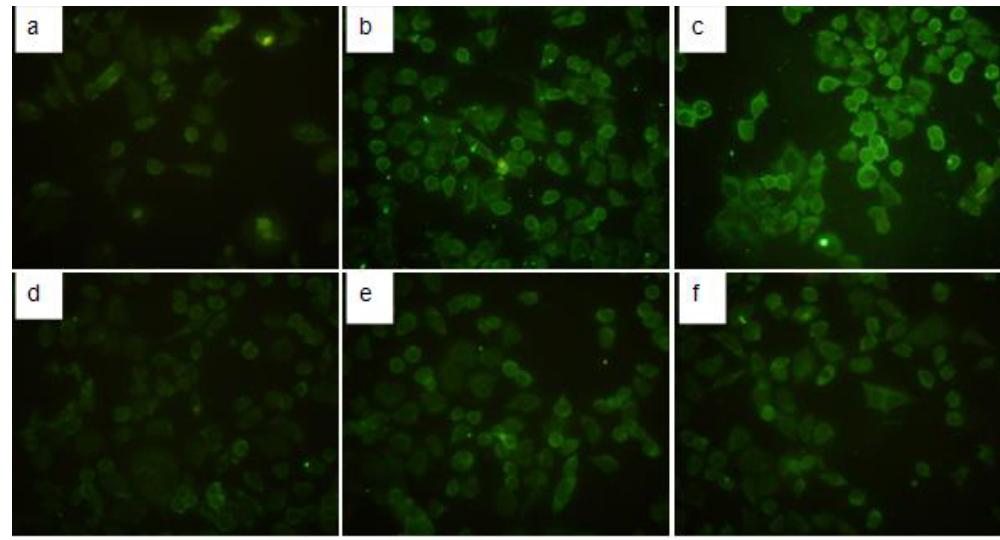
Figure 6. The comparison of TGF- β 1 Immunofluorescence results in six different stimulation groups. ( a ) TGF- β 1 expressed in normal HMCs; ( b ) TGF- β 1 expressed in HMCs under the stimulation of pIgA1; ( c ) TGF- β 1 expressed in HMCs under the stimulation of pGSN and PIgA1; ( d ) TGF- β 1 expressed in HMCs under the stimulation of NIgA1; ( e ) TGF- β 1 expressed in HMCs under the stimulation of pGSN and NIgA1;and ( f ) TGF- β 1 expressed in HMCs under the stimulation of pGSN (immunofluorescence, 200 × ). Each group contains six samples ( n = 6), the between-group differences were calculated with a one-way ANOVA and LSD test, the results arepresented as means ± standard deviation (SD).